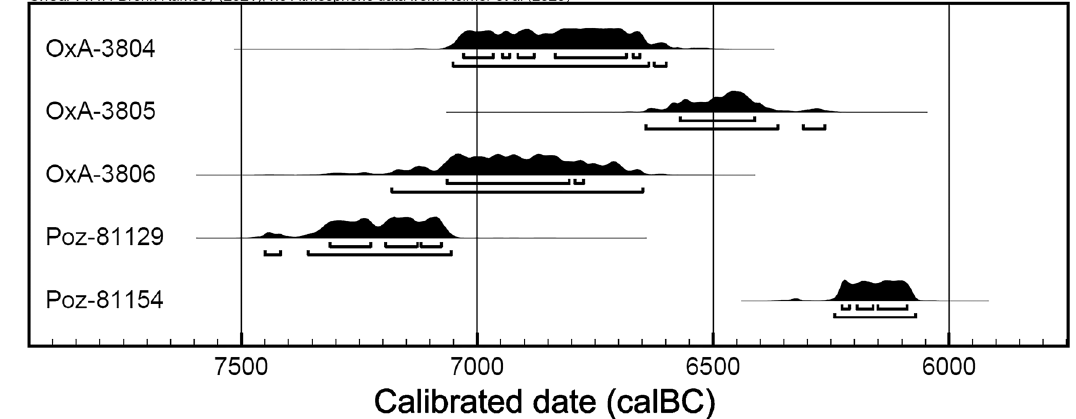
Figure 3: Vasylivka II. Plot of calibrated BC radiocarbon measurements on human